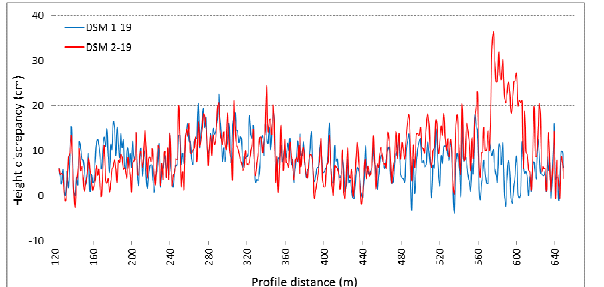
Figure 13. Ellipsoidal height discrepancy between the GNSS profile and the DSMs extracted profiles